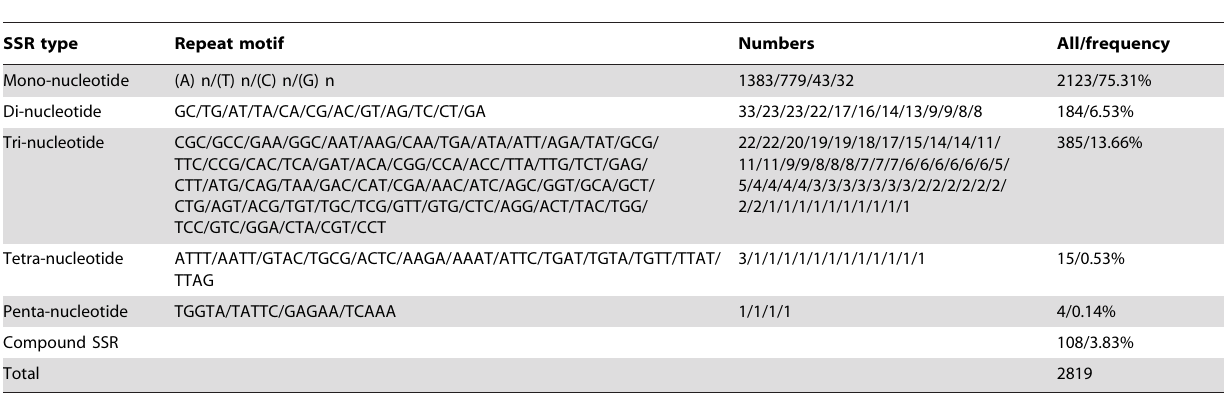
Table 4. Summary of simple sequence repeat (SSR) types in the A. lepigone transcriptome.